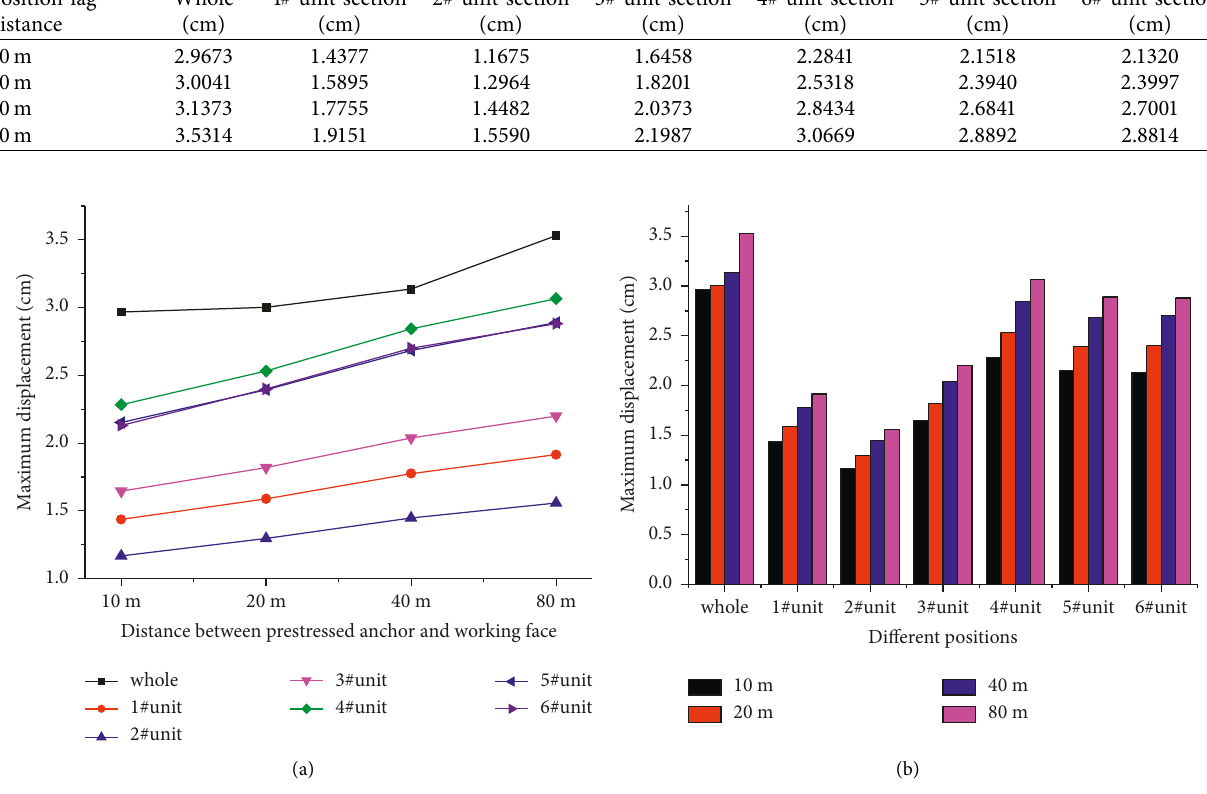
6#unit5#unit4#unit3#unit2#unit1#unitwhole